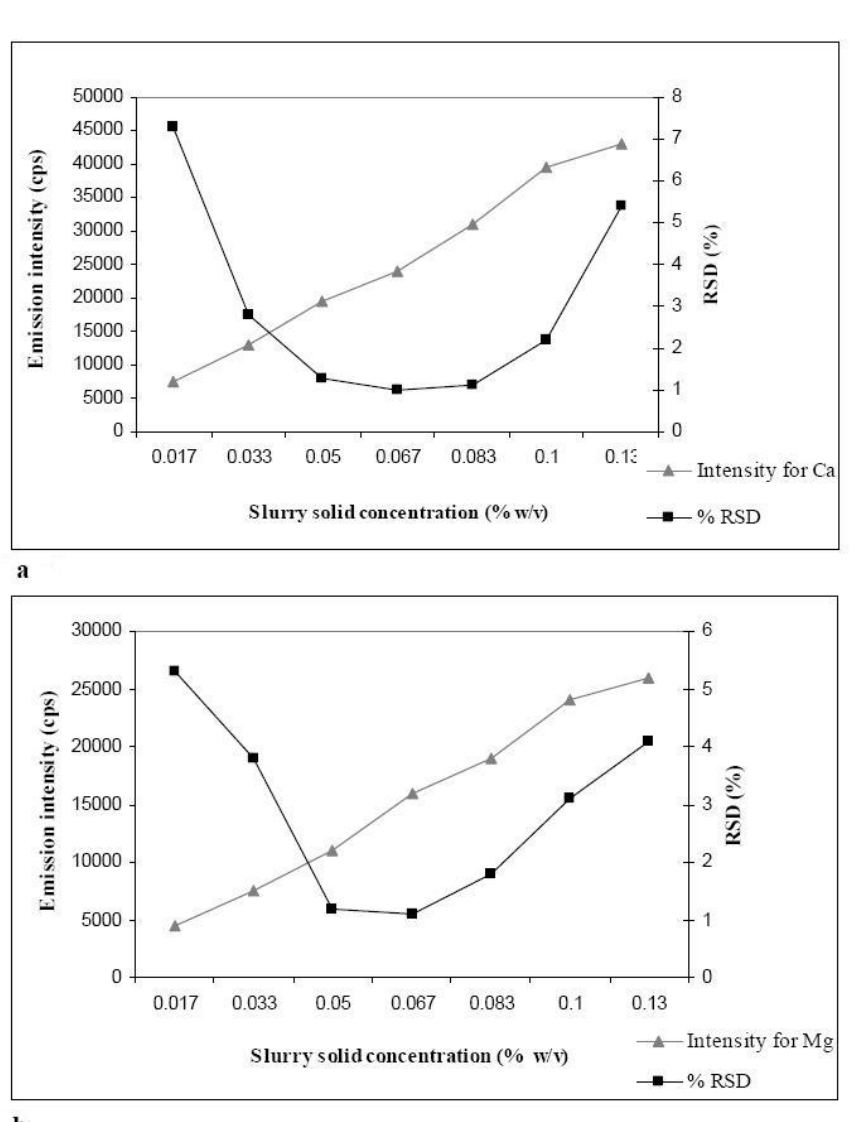
Fig. 3 (a) Ca signal and precision during slurry nebulization ICP-OES. (b) Mg signal and precision during slurry nebulization